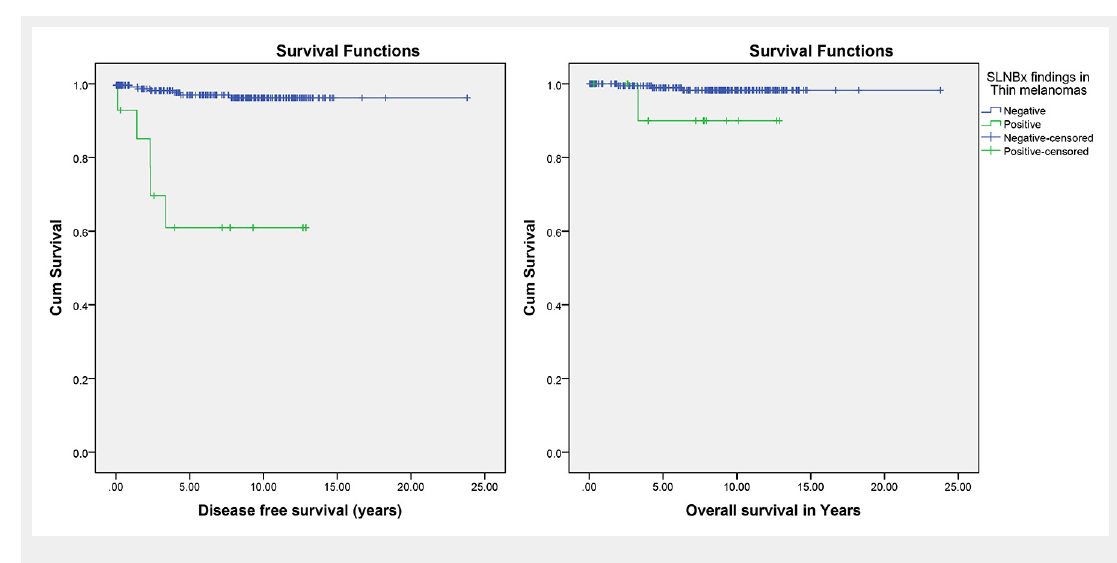
Effect of sentinel lymph node biopsy (SLNBx) result on disease-free and overall survival in thin melanoma (p <0.001 and p = 0.077, respectively).